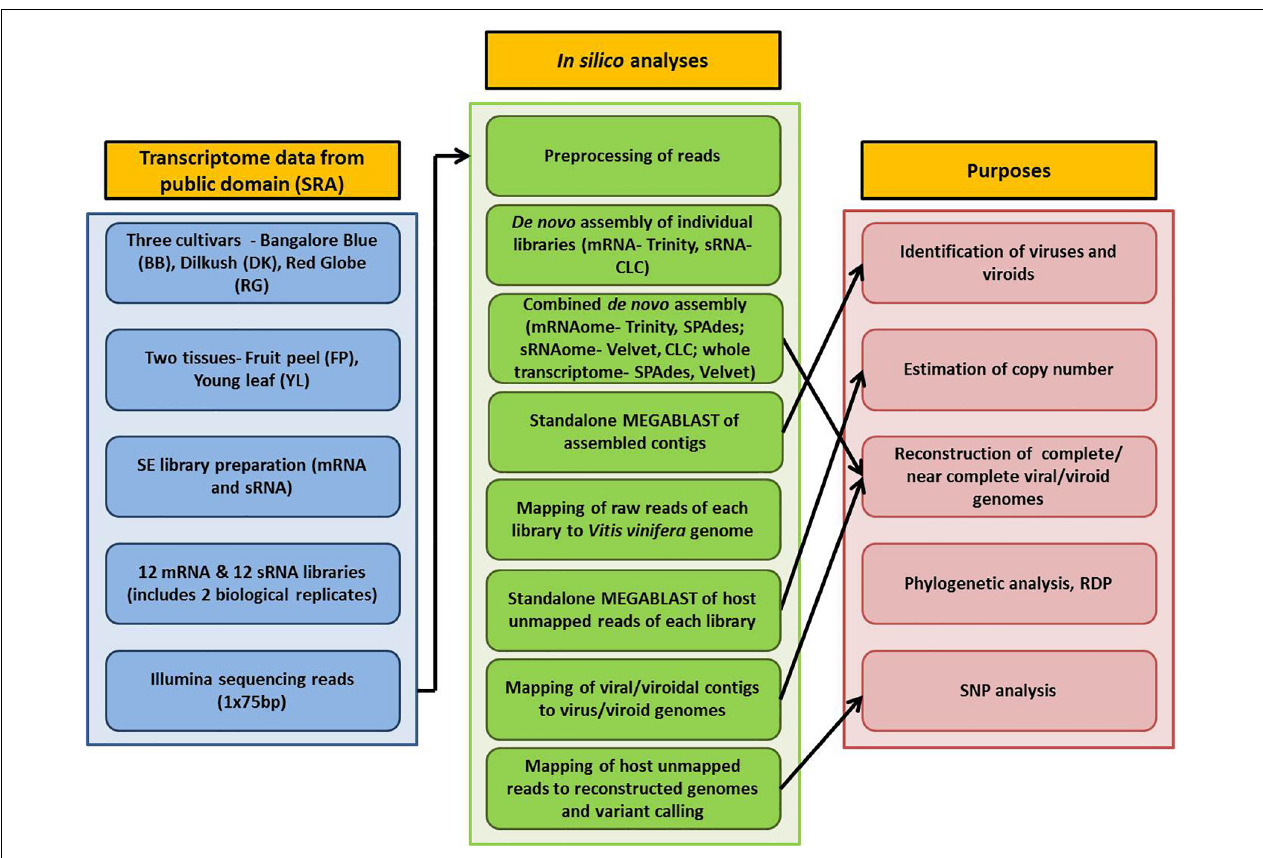
FIGURE 1 | Schematic representation of the viromic study of three Indian grapevine